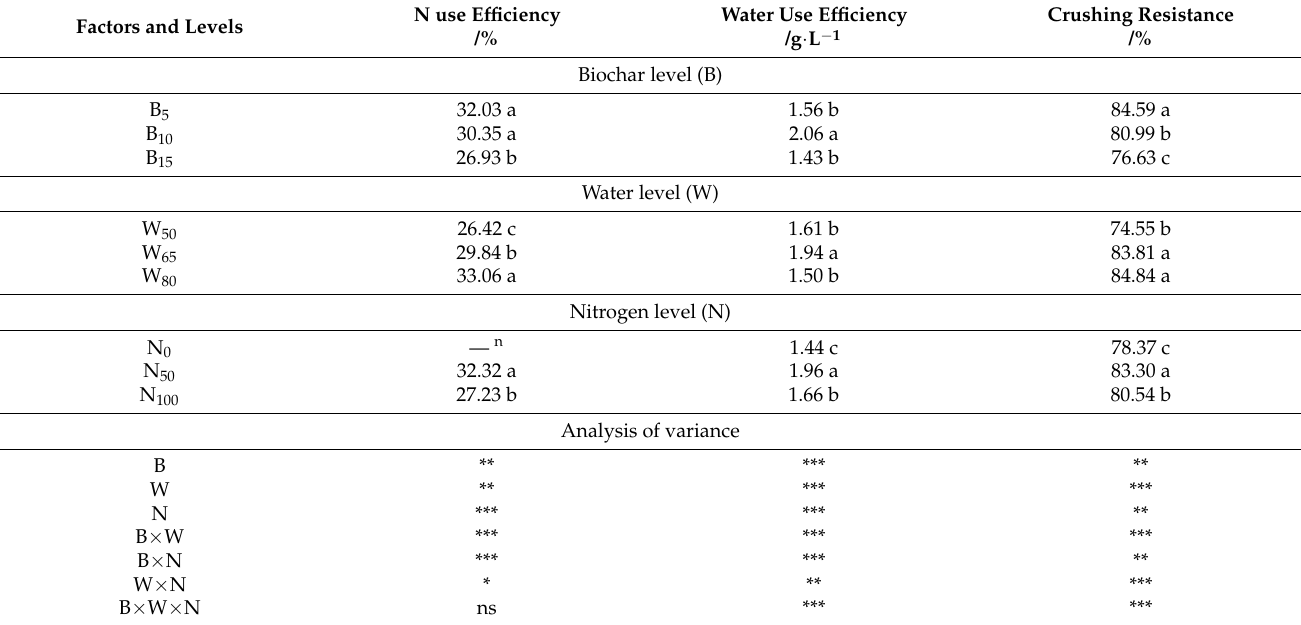
Table 2. N use efficiency, water use efficiency, and crushing resistance of cucumber seedlings. Factors and